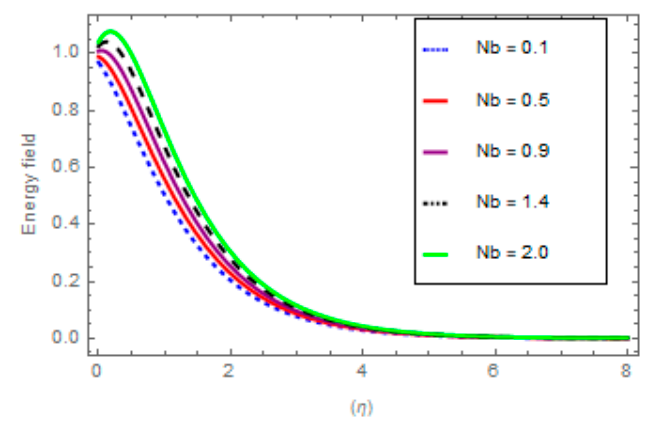
Figure 8. Result of Ec via θ ( η ) .